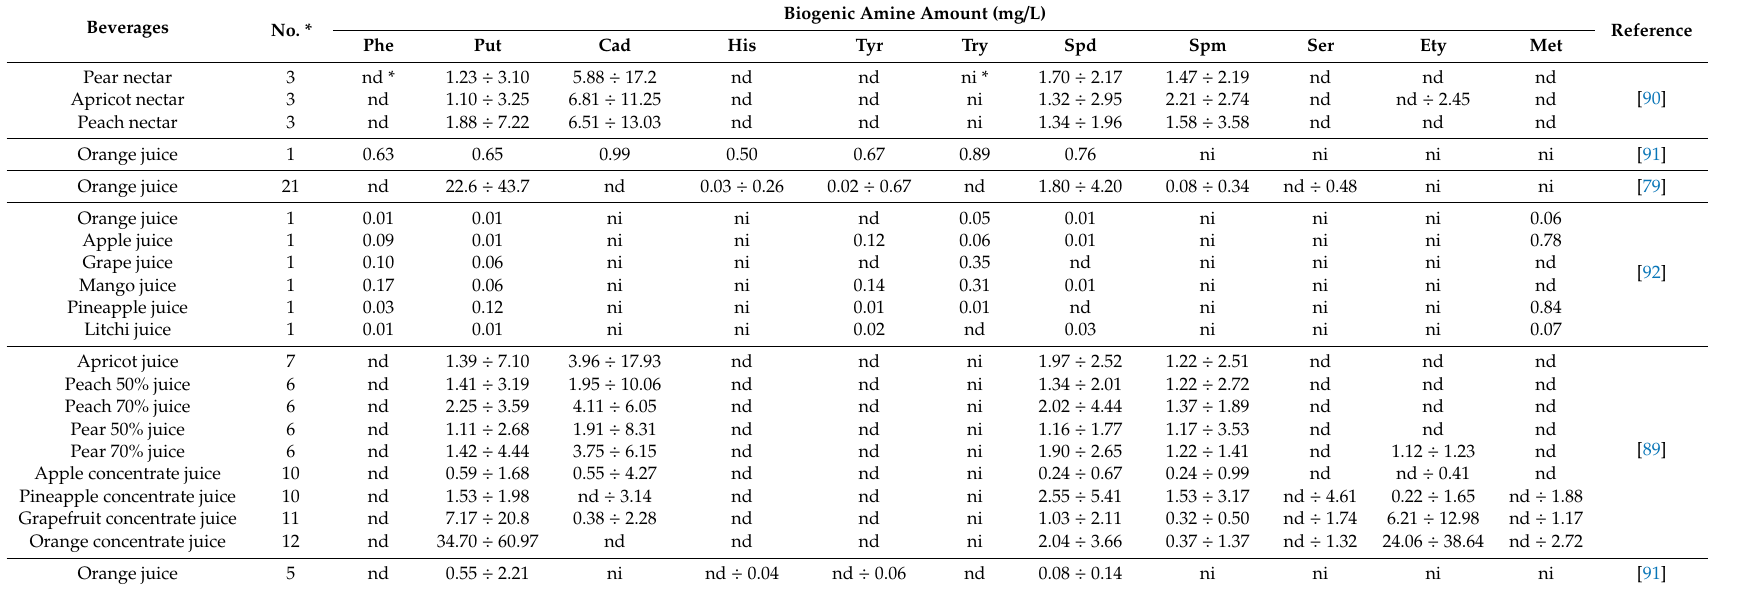
Table 4. Biogenic amine amount in fruit